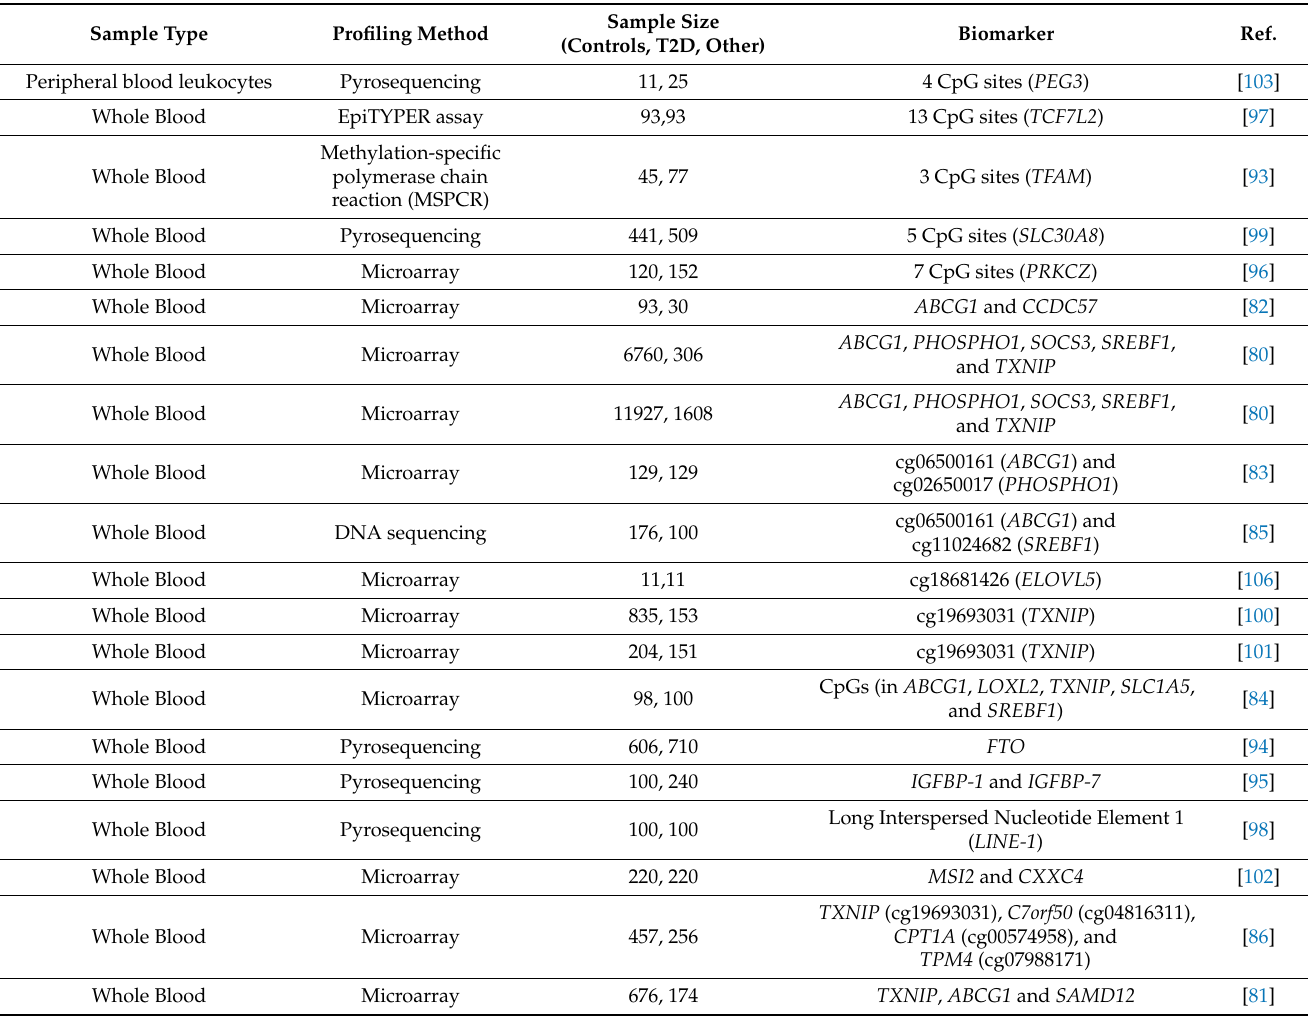
Table 7. DNA methylation biomarkers from blood samples for